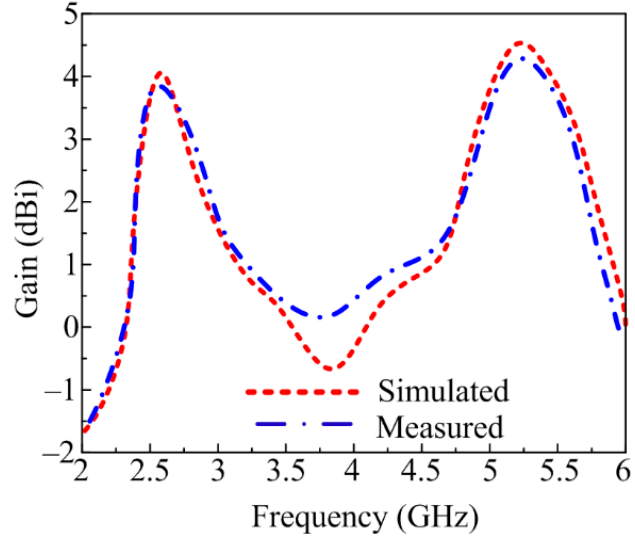
Figure 9. Comparison between measured and simulated gain of suggested antenna.